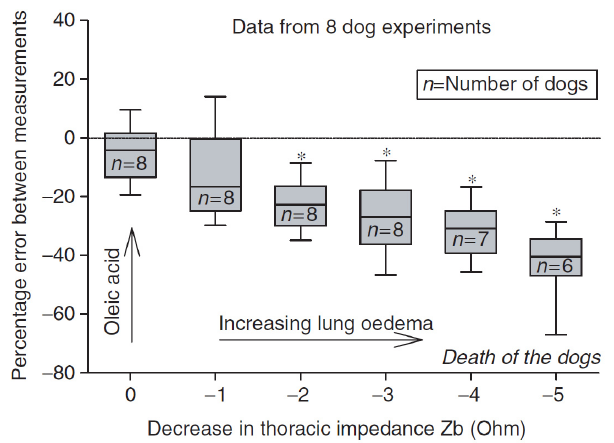
Fig. 10. Box plots showing that, as oleic acid-induced pulmonary edema worsened, as reflected by decreasing Z 0 , the systematic underestimation of flow-probe CO by ICG-derived CO increased. From reference